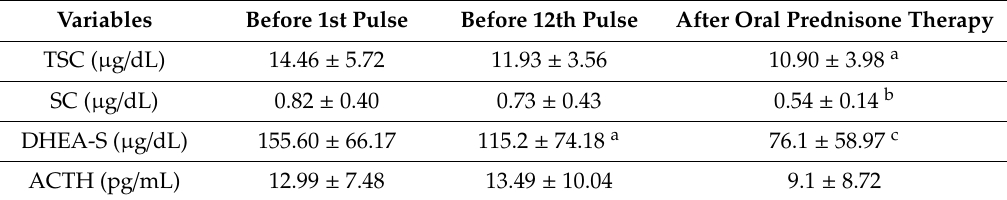
Table 1. The results at three time